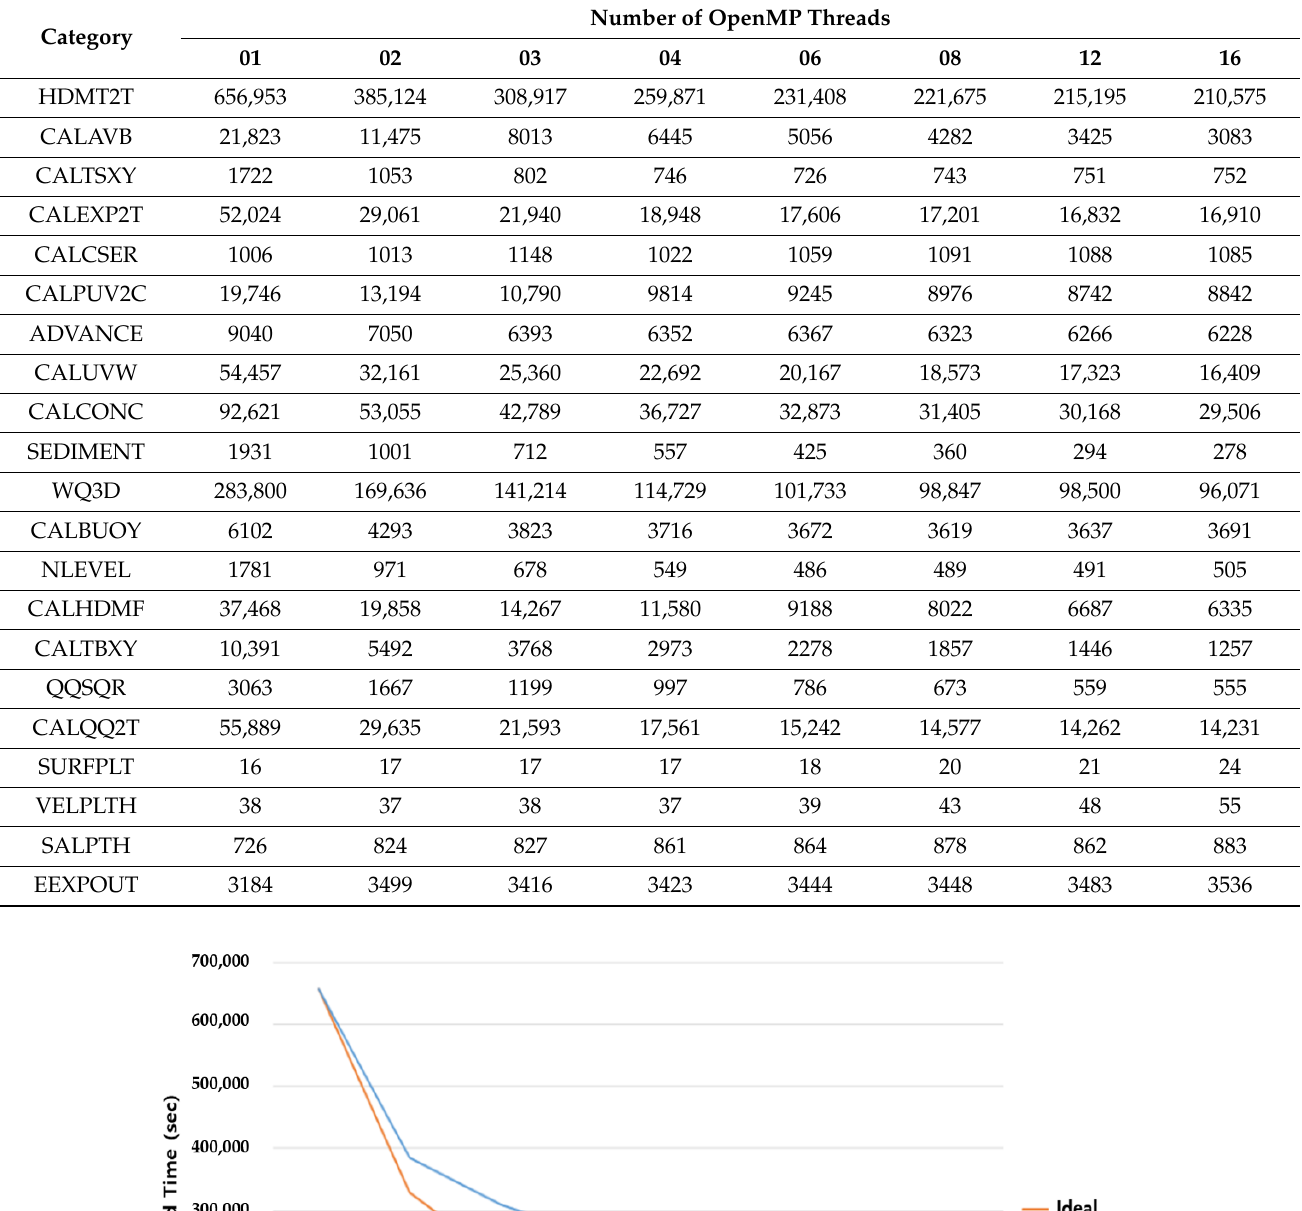
Table A6. Execution time for each function based on the number of OpenMP threads. Table C2. Execution time for each function based on the number of OpenMP threads.